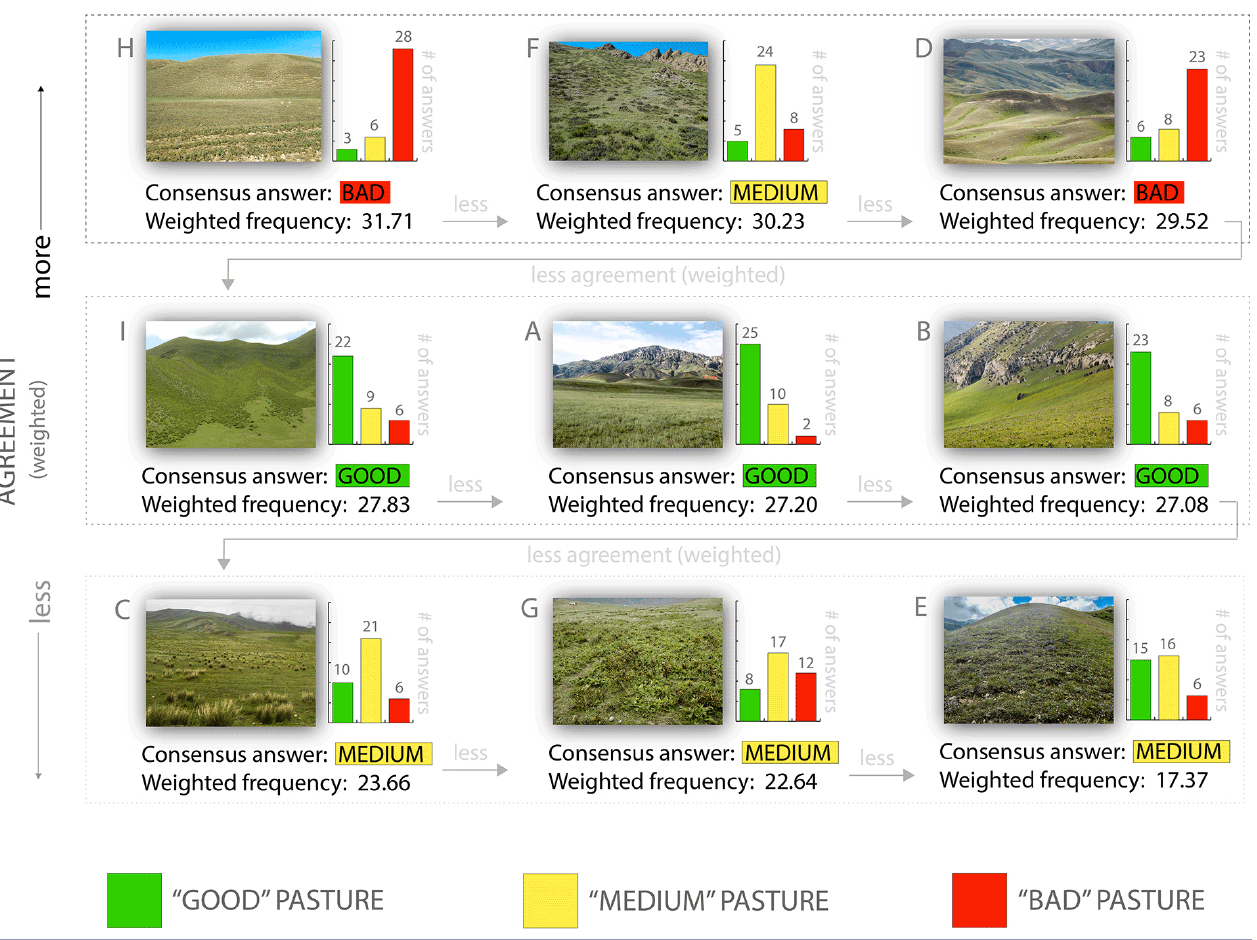
Fig. 3 . Landscape images and sortings arranged from highest to lowest degree of interparticipant agreement (measured by UCINET’s weighted frequency function), grouped by